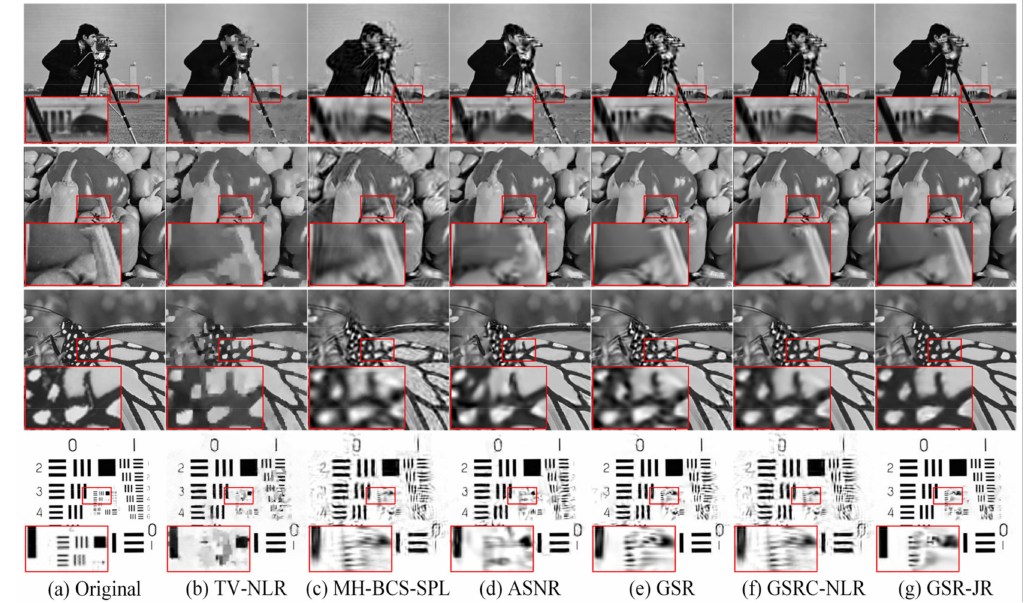
Figure 9. Visual effects of reconstructed images with various reconstruction models when R =